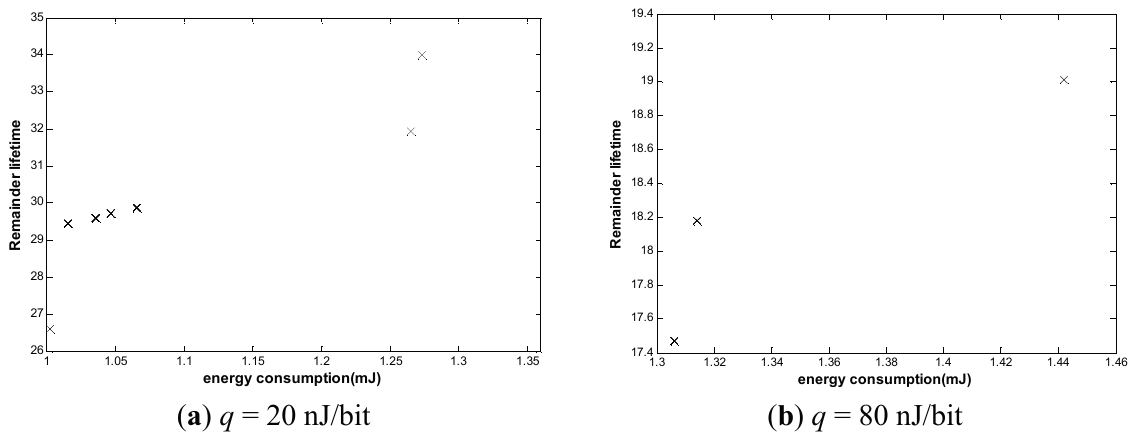
Figure 8. Pareto Front when ε =